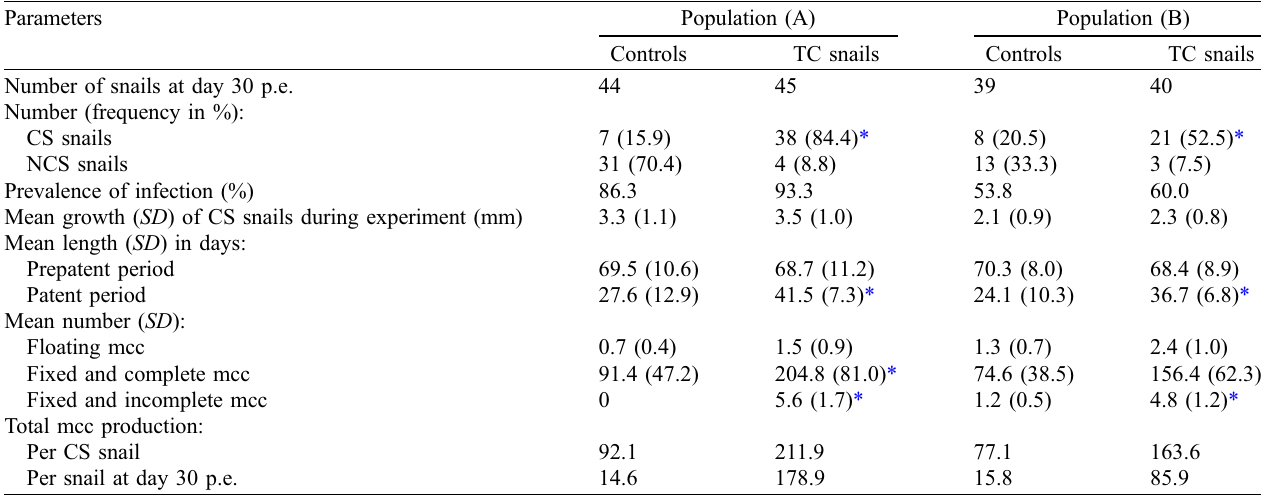
Table 3. Main characteristics of P. daubneyi infection in snails maintained to a constant temperature of 20 (cid:2) C (controls), or subjected